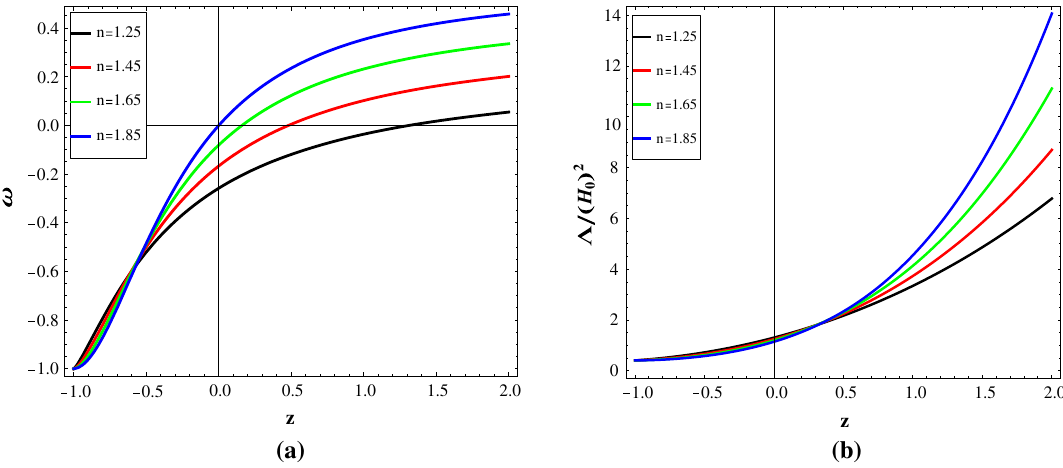
Fig. 4 The plots of the EoS parameter ω and cosmological constant (cid:3) vs. redshift z with λ = −